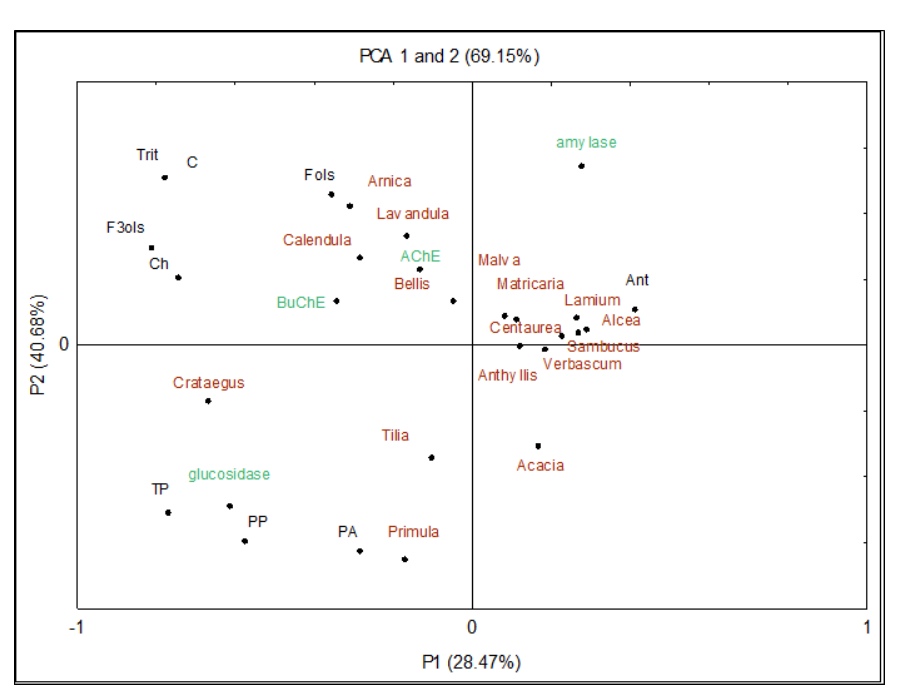
Figure 1. Principal Component Analysis (PCA) scores plot showing the relationship among bioactive compounds and biological activity of selected edible flowers. Tri—triterpenoids; C—carotenoids; F3ols—flavan-3-ols (monomers and dimers); Ch—chlorophylls; Fols—flavonols; Ant—anthocyanins; TP—total polyphenols; PP—polymeric procyanidins; PA—phenolic acids.